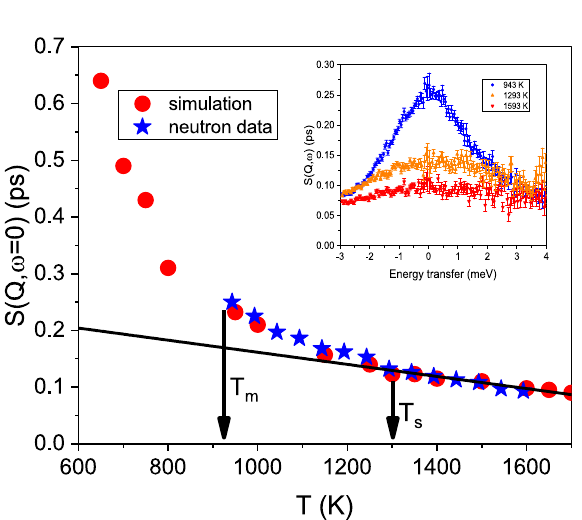
Figure 1. Energy and time spectra are presented, obtained through the different methods. Panel ( a ) shows a comparison between the neutron spectra and the AIMD spectra for two temperatures to demonstrate the nearly perfect agreement on lineshape and also absolute amplitude. Panel ( b ) displays a comparison between the intermediate scattering function F ( Q 0 , t ) from the Fourier transformed x-ray spectra and the simulation results for two temperatures on a logarithmic time axis. Panel ( c ) depicts experimental F ( Q 0 , t ) for three temperatures with KWW-function fits included as a line. The inset shows the data on a logarithmic scale to demonstrate the nearly exponential decay in this temperature range. Panel ( d ) shows the simulated F ( Q 0 , t ) data for 5 temperatures on a logarithmic scale including fits with KWW relaxation functions.